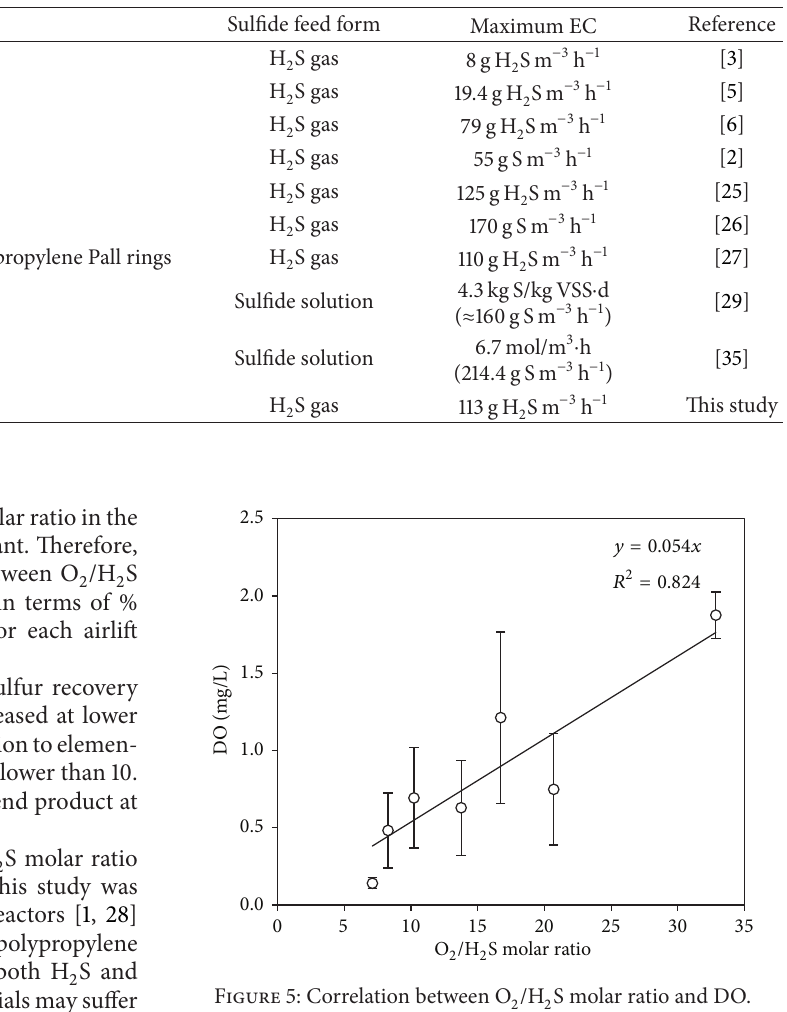
Table 1: Comparison between the maximum elimination capacity of the current airlift bioreactor and other studies.